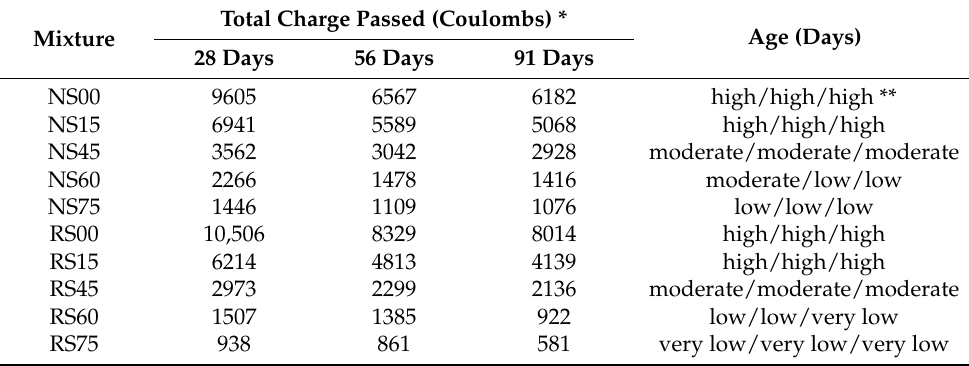
Table 6. Measured results of the resistance to chloride-ion penetration of concretes.